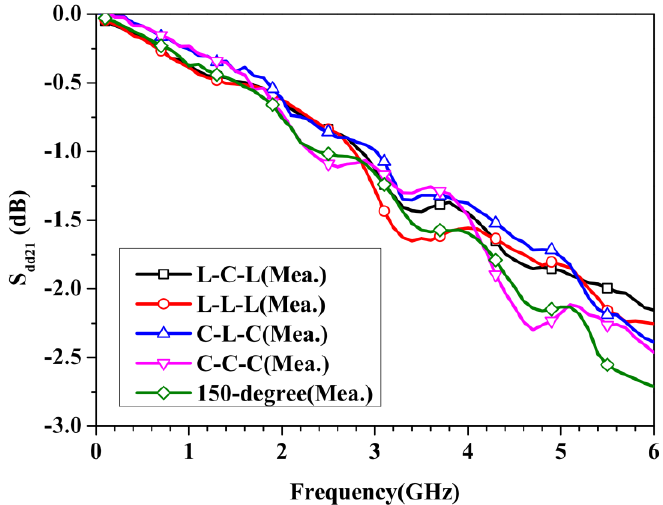
Figure 15. The measured results for Sdd21.